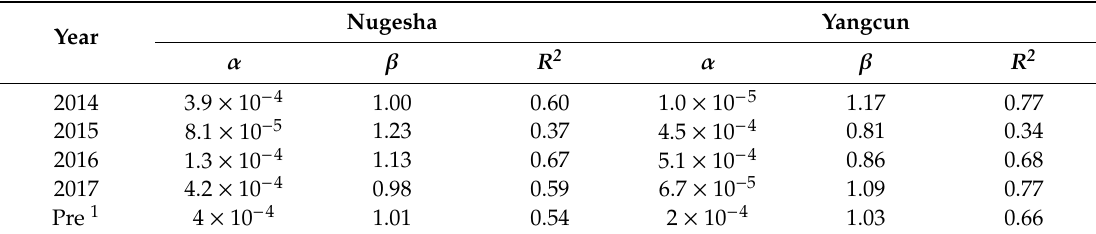
Table 5. Fitting of the sediment rating curves at the Nugesha and Yangcun